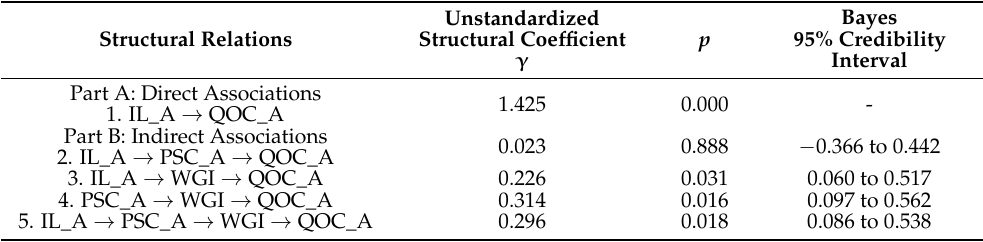
Table 5. Hypotheses testing.